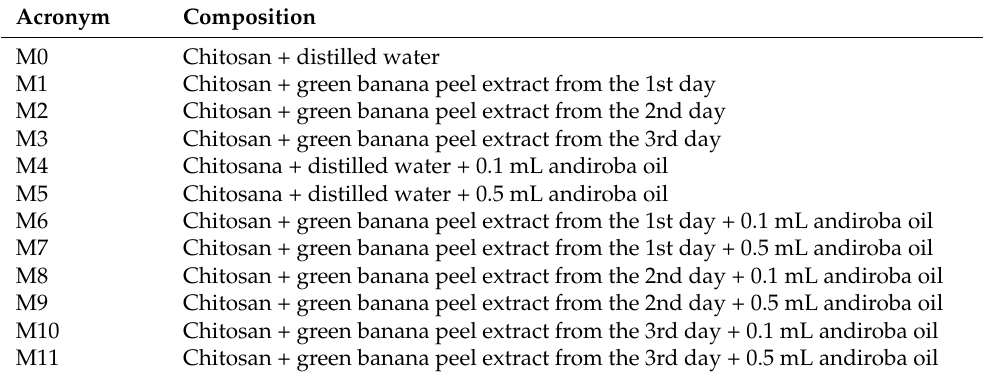
Table 2. Description of the acronyms and composition of the synthesized membranes.